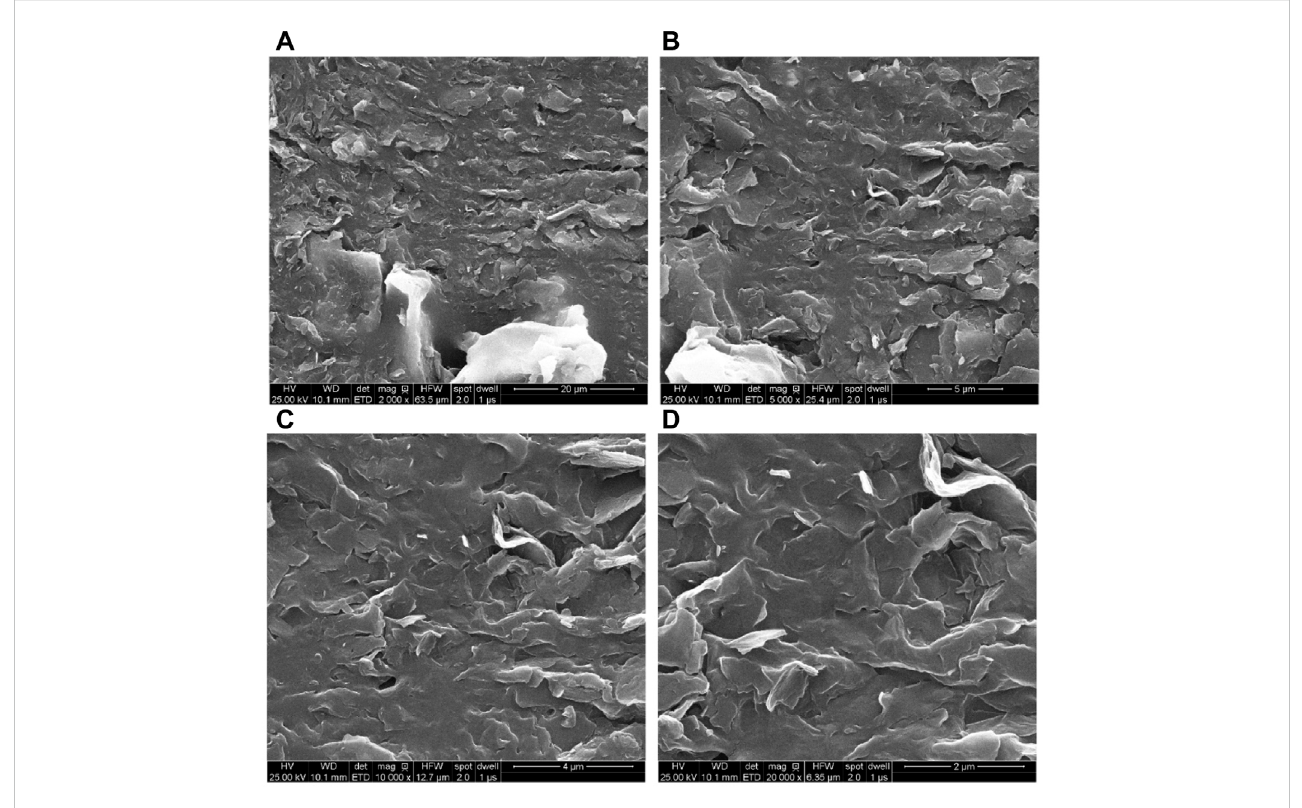
FIGURE 14 SEM image of the mature gel. The magni fi cation of (A) , (B ), (C) and (D) are 2000, 5,000, 10,000, and 20,000 respectively (Li et al.,